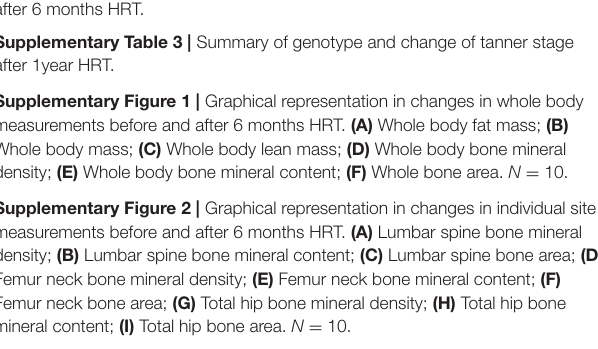
Supplementary Table 1 | Basic clinical data of normal 18-year-old girls. Supplementary Table 2 | Change of bone mineral status and body composition after 6 months HRT. Supplementary Table 3 | Summary of genotype and change of tanner stage after 1year HRT. Supplementary Figure 1 | Graphical representation in changes in whole body measurements before and after 6 months HRT. (A) Whole body fat mass; (B) Whole body mass; (C) Whole body lean mass; (D) Whole body bone mineral density; (E) Whole body bone mineral content; (F) Whole bone area. N = 10. Supplementary Figure 2 | Graphical representation in changes in individual site measurements before and after 6 months HRT. (A) Lumbar spine bone mineral density; (B) Lumbar spine bone mineral content; (C) Lumbar spine bone area; (D) Femur neck bone mineral density; (E) Femur neck bone mineral content;